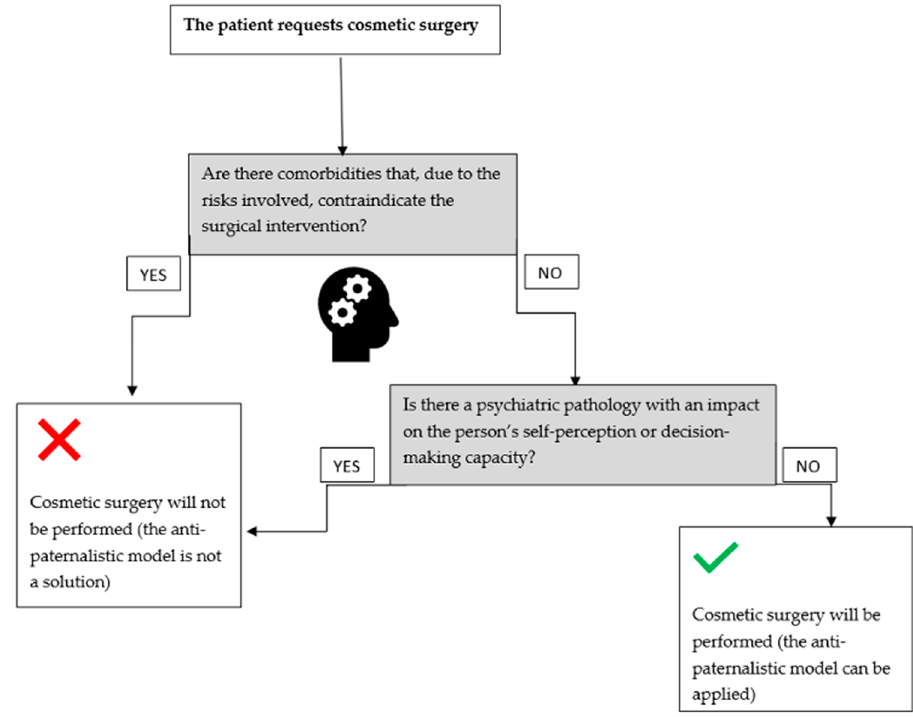
Figure 1. The algorithm for the anti-paternalistic model applicability when a patient requests cosmetic surgery [4,8].